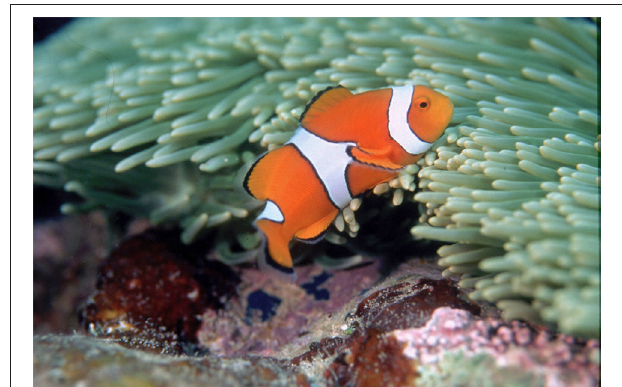
FIGURE 1 | Photo of the clown anemonefish Amphiprion percula, illustrating the conspicuous orange, white and black coloration of the genus. In fishes, chromatophores, containing either colored droplets (xanthophores and erythrophores) reflecting organelles (iridophores) or pigment granules (melanophores), are responsible for skin coloration. In Amphiprion , the orange color is carotenoid based, the white color (which also reflects in the UV) is likely a structural color based on intracellular stacks of guanine crystals, and the black color is melanin based. Coloration of other members of the genus can be seen on FishBase (Froese and Pauly, 2018). [http://www.fishbase.org/